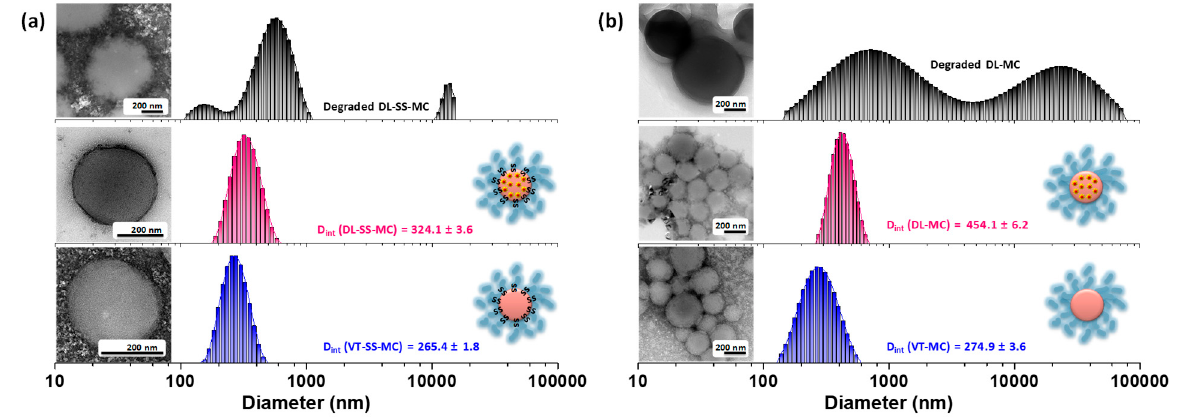
Figure 2. ( a ) DLS diagrams and TEM images of VT-SS-MC, DL-SS-MC, and degraded DL-SS-MC at pH 5.5/37 °C in the presence of 10 mM GSH. ( b ) DLS diagrams and TEM images of VT-MC, DL-MC, and degraded DL-MC at pH 5.5/37 °C. Scale bar = 200 nm.